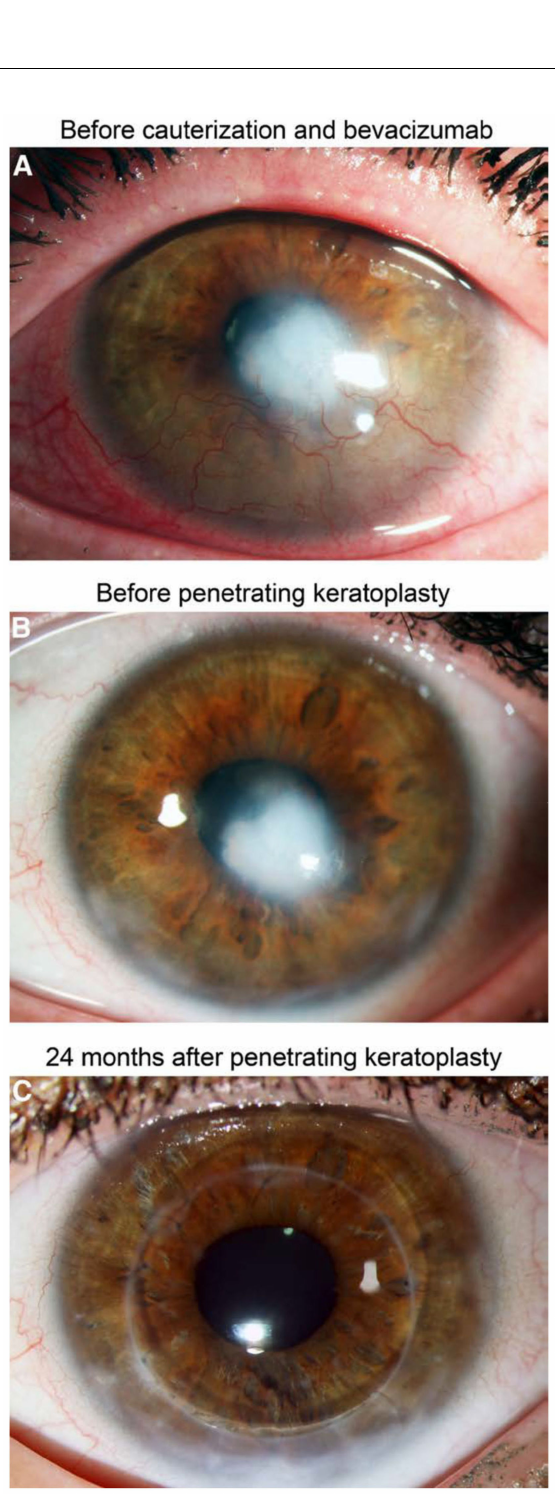
Figure 11. Clinical follow-up of a patient with corneal neovascularization treated with fine-needle diathermy (FND) and bevacizumab application before penetrating keratoplasty. In this eye, no graft rejection was observed. ( A ) Herpetic corneal scar with corneal neovascularization in the lower corneal quadrants before FND and bevacizumab application. ( B ) Corneal scar without neovascular- ization 6 months after FND and bevacizumab application (1 day before penetrating keratoplasty). ( C ) Clear cornea without any signs of allograft rejection 24 months after penetrating keratoplasty. From Hos et al. 2019